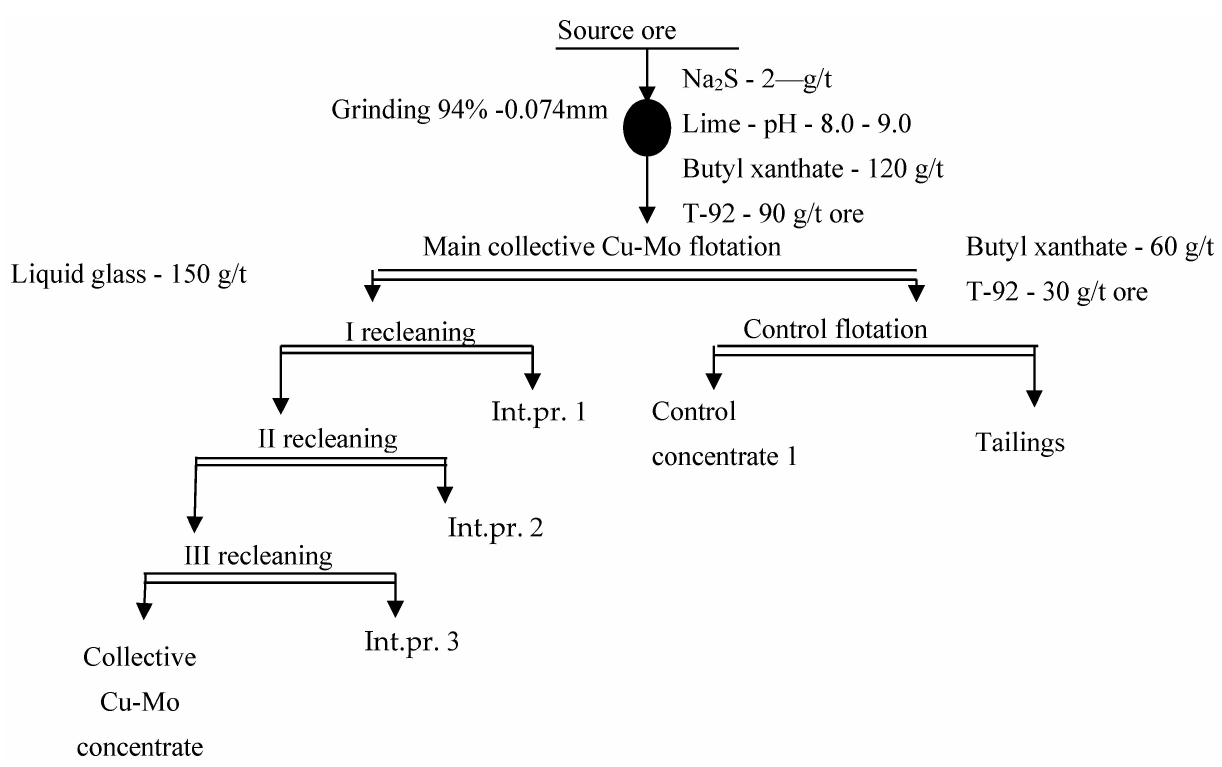
Figure 5. Scheme of collective copper-molybdenum ore flotation. Int.pr is the abbreviation of Intermediate